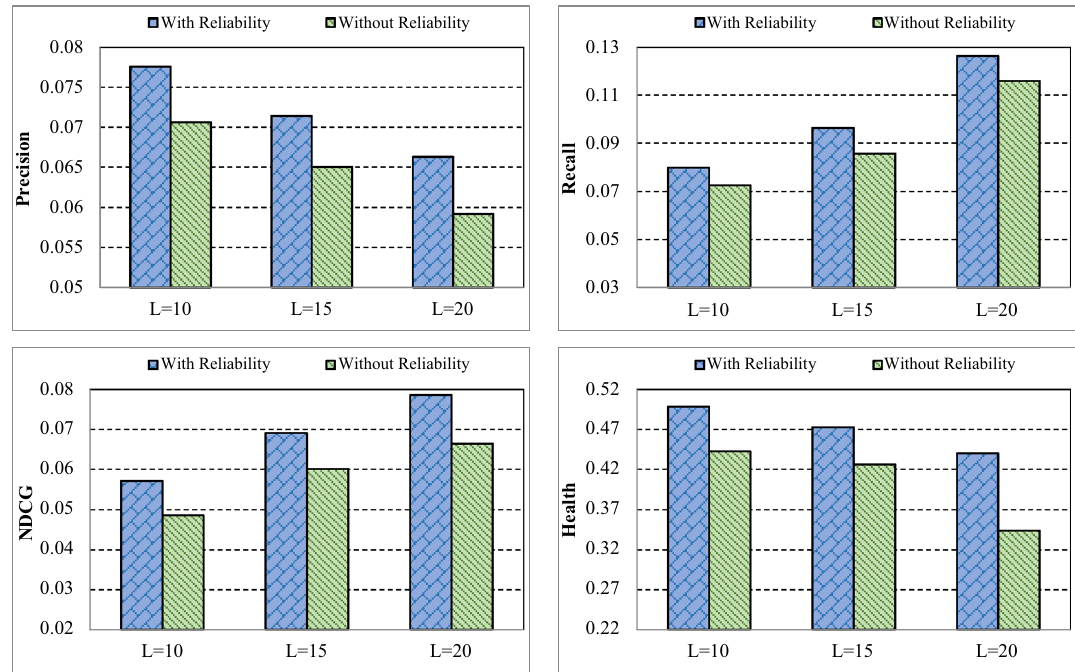
Fig. 6 The comparison of the proposed FRSHR method with the model obtained by ignoring the reliability